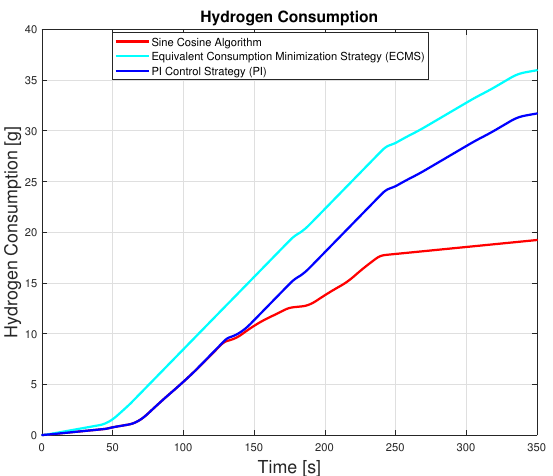
Figure 11. Change of hydrogen consumption during simulation (Benchmark Study).